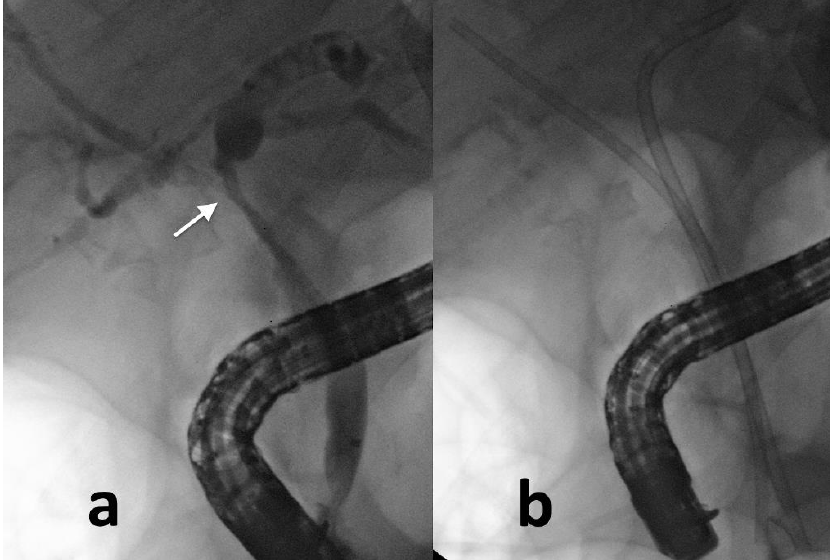
Figure 1. Gallbladder cancer invading the main hepatic confluence (arrow) ( a ); two plastic stents ( b ) are inserted to drain the bile ducts and to obtain jaundice relief. ( b ) are inserted to drain the bile ducts and to obtain jaundice